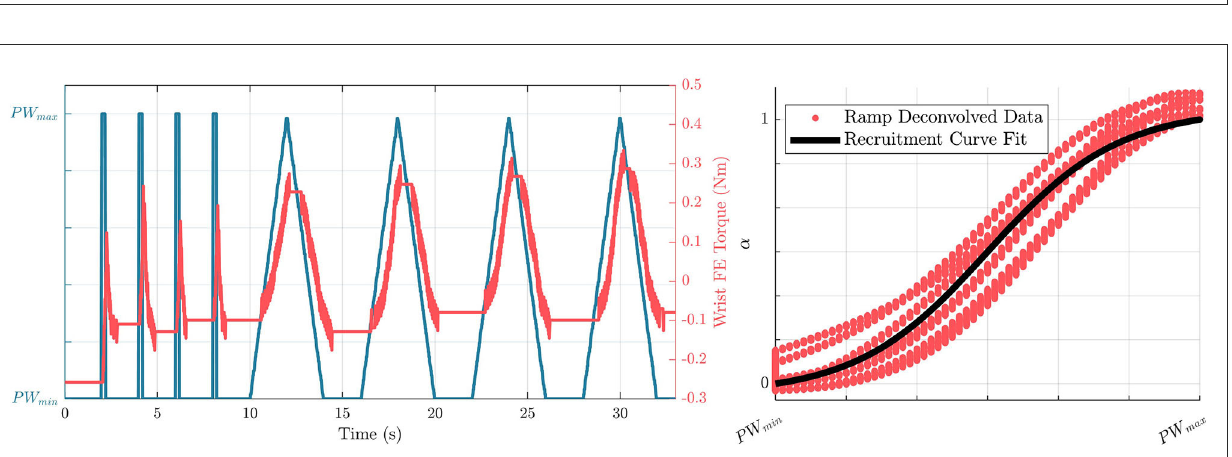
FIGURE3 (Left) Profiles of commanded pulsewidths, and resulting torque outputs due to stimulation from the wrist extension electrode in the recruitment curve characterization process. (Right) Resulting characterized recruitment curve in the form of a sigmoid based on the ramp deconvolved